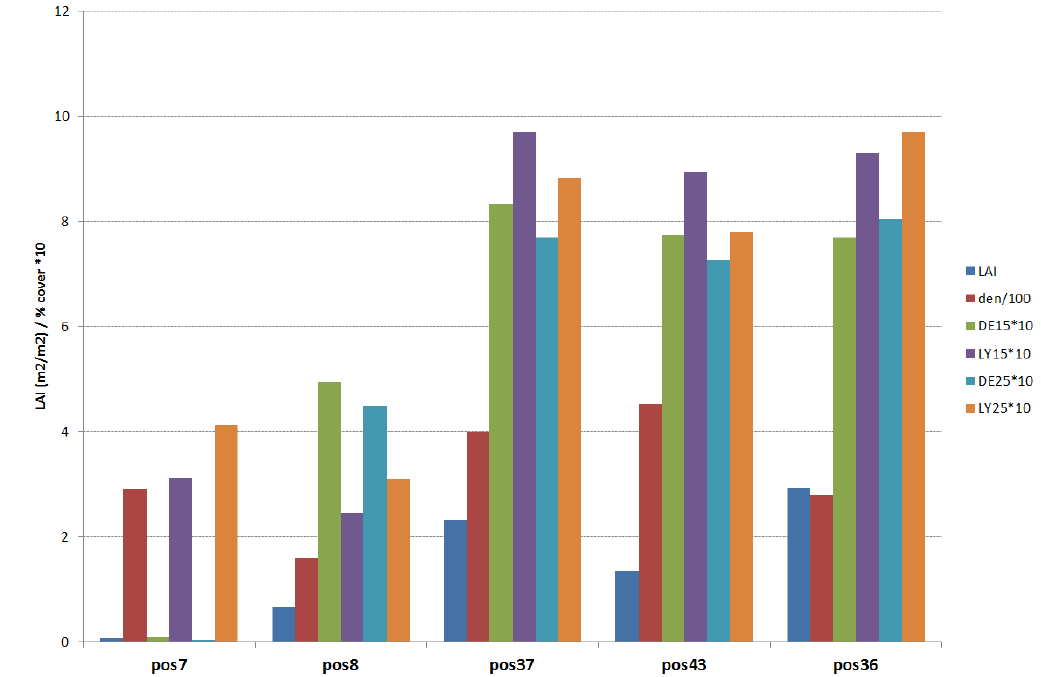
Figure 8. LAI and PO density (shoots/m 2 ) rescaled point measurements and corresponding corver focal densities derived from classification of Daedalus ATM reflectances (DExx) and Lyzenga indices (LYxx).